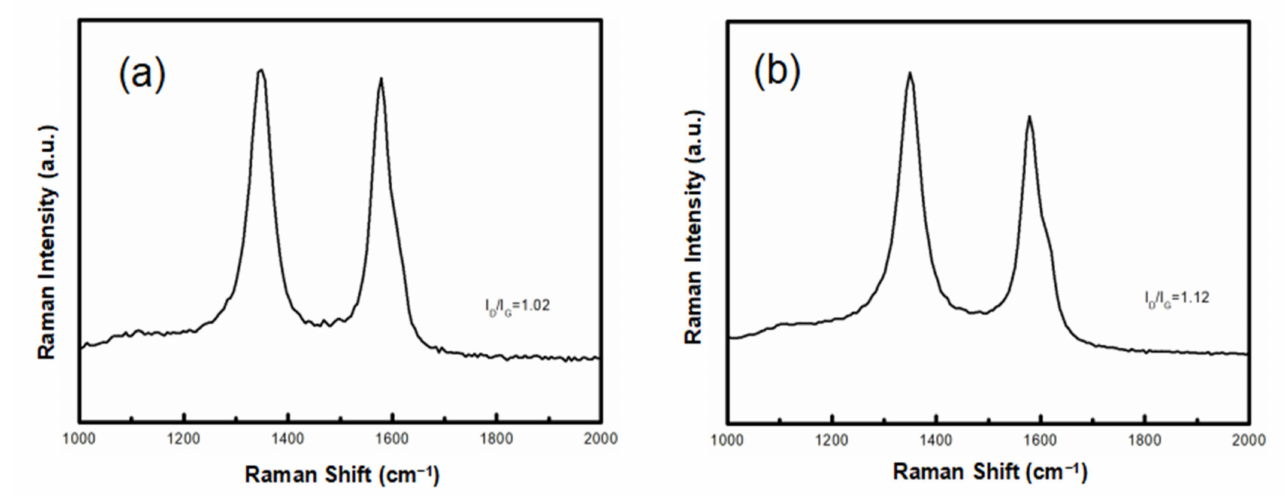
Figure 3. Raman spectra of CNTs. ( a ) pristine CNTs and ( b ) surface treated CNTs.